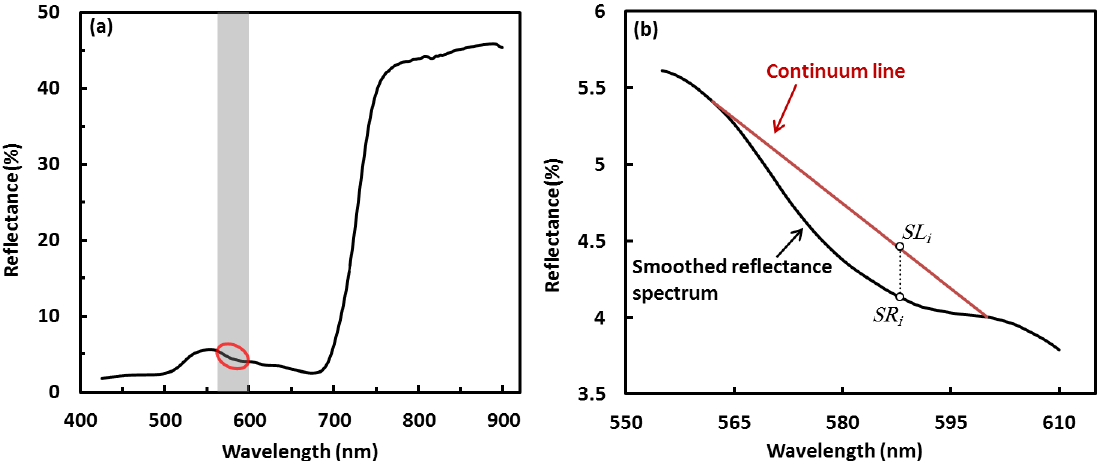
Figure 3. ( a ) The absorption feature related to leaf chlorophyll concentration in the spectral region of 562–600 nm. ( b ) Continuum removal applied to the absorption